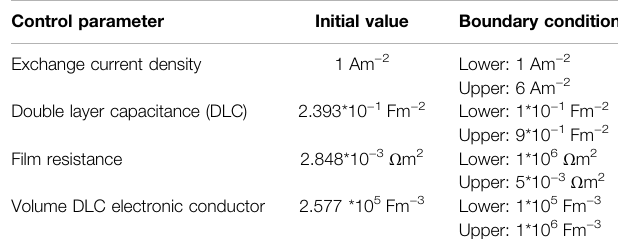
TABLE 2 | Control parameters with a cell voltage of 3.10